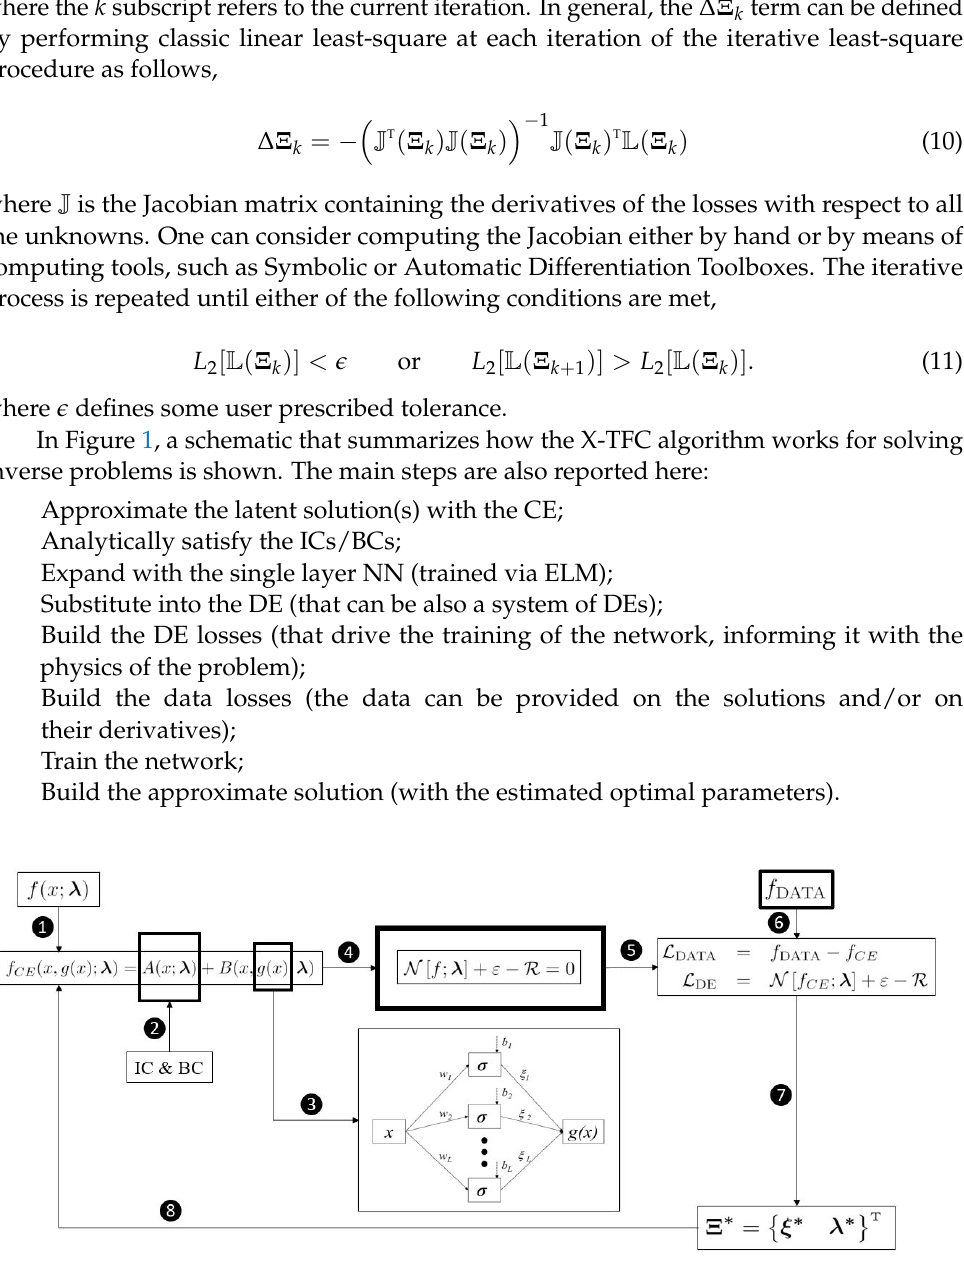
Figure 1. Schematic of the X-TFC framework for solving inverse